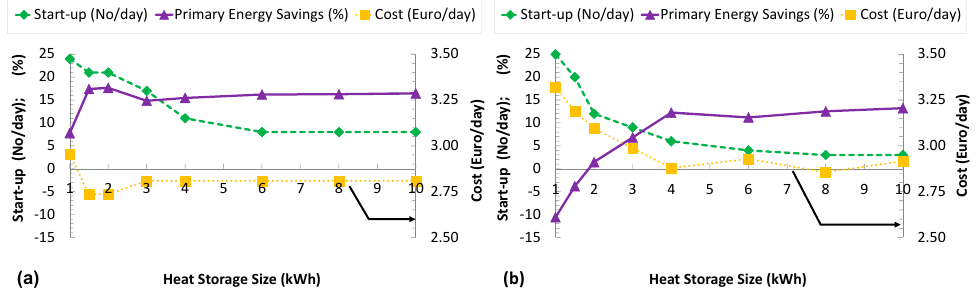
Figure 5. Computational results of the optimal scheduling of a small-size Stirling unit for the case study of a residential flat in Northern Italy during a typical winter day: ( a ) Without and ( b ) with startup and shutdown penalization. The number of startups and the primary energy savings are on the left-hand side axis and the objective function, which is the daily costs of operation, on right one.